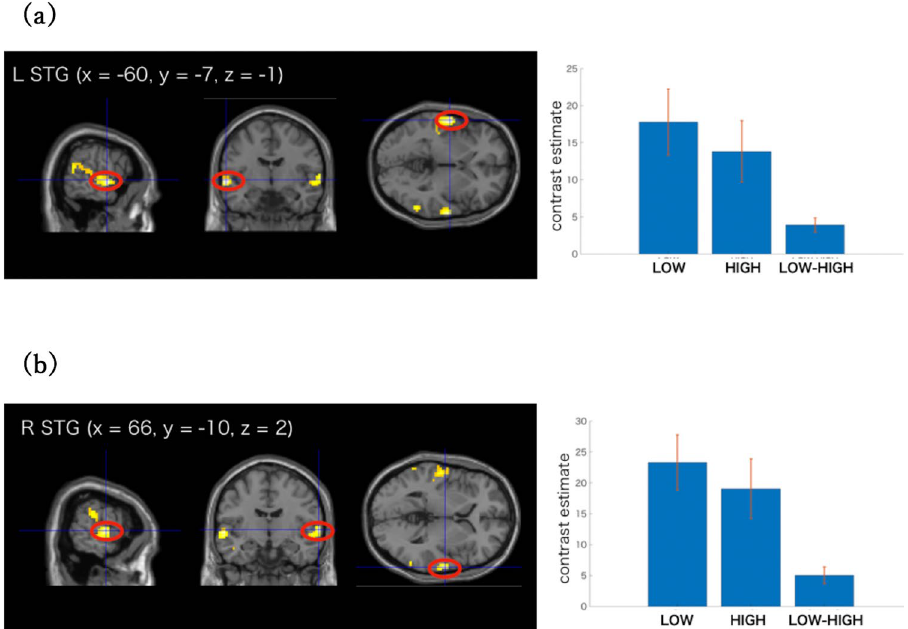
Figure 3. LOW–HIGH contrast. ( a ) Left: Significant voxels for the LOW–HIGH contrast. Right: contrast estimates for LOW, HIGH, and LOW – HIGH in the left STG. ( b ) Left: Significant voxels for the LOW–HIGH contrast. Right: Contrast estimates for LOW, HIGH, and LOW–HIGH in the right STG. Displayed contrasts were significant at a voxel-level threshold of p < .001 combined with an FWE correction of p < .05 for cluster size. The error bars represent 90% confidence